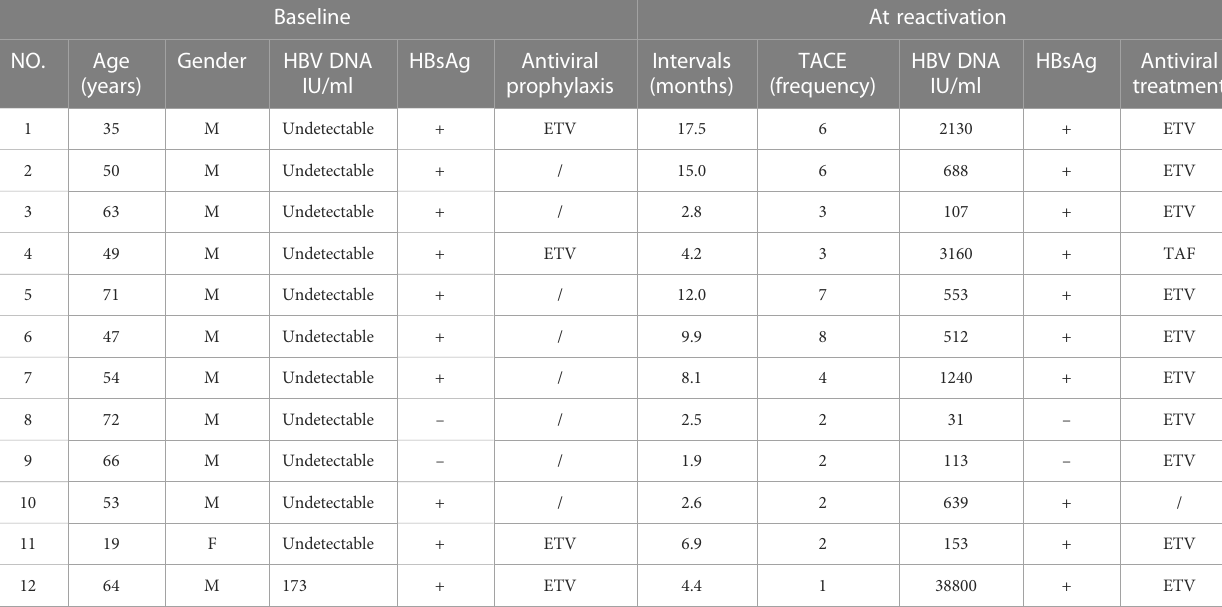
TABLE 2 Details of 12 patients with HBV